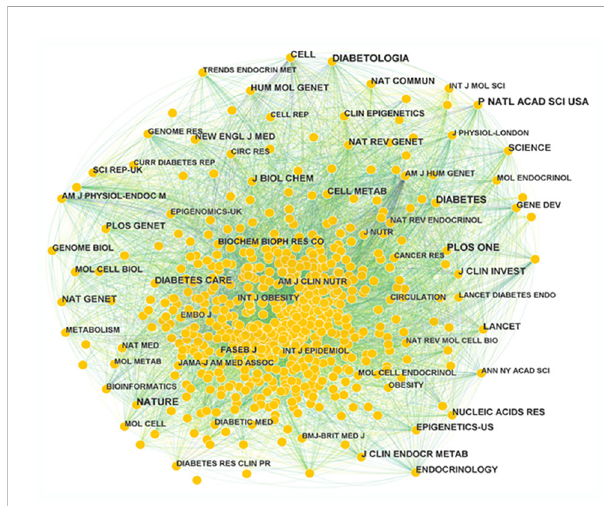
FIGURE 5 Map of publication journals. Different sizes denote the quantity of publications for publication journals, and the distance between the two circles represents the relatedness between